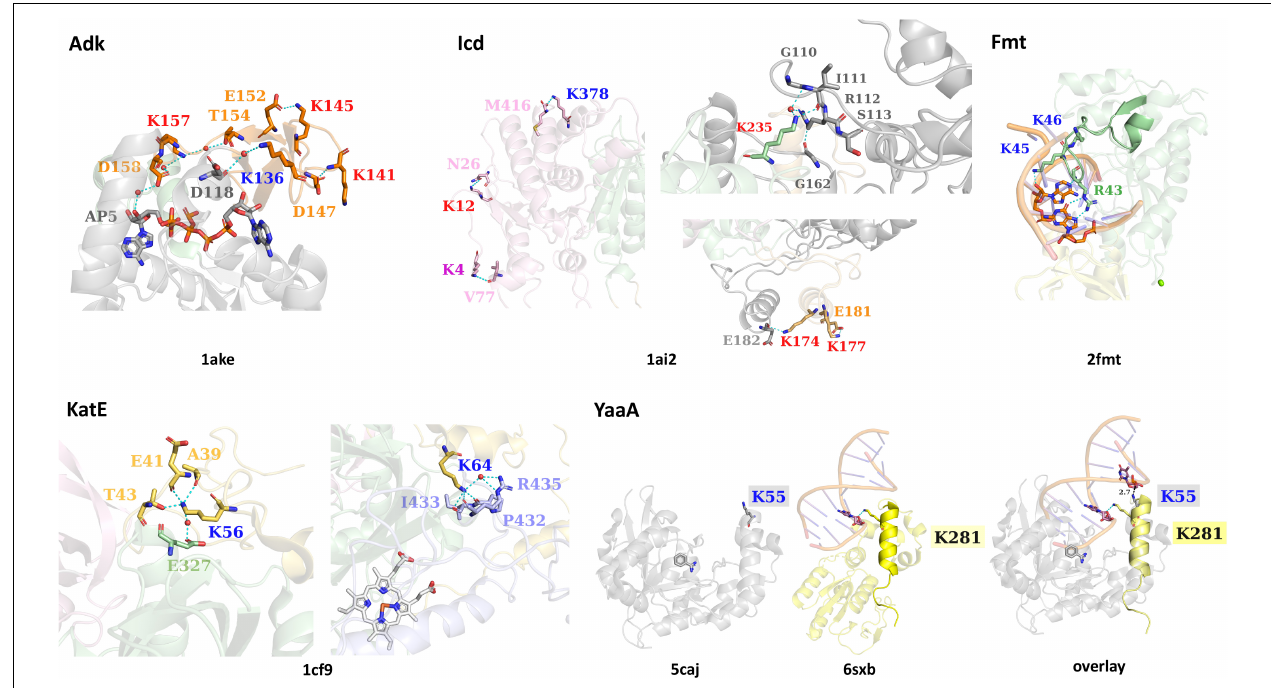
FIGURE 3 | The interactions of lysine residues identified as acetylated in E. coli K-12 KAT protein substrates Adk, Icd, KatE, Fmt, and YaaA. Structures of each substrate protein are colored by domains as in Figure 1 and PDB IDs are shown beneath each substrate protein structure. Residues surrounding KAT or AcP lysine sites of acetylation and interact via H-bonding are shown as sticks and colored by domain. Cyan dashes are used for H-bonding interactions and black dashes (in the YaaA structure) show distance measurements. Ligands are shown in sticks and water molecules are red spheres. Specific lysine residue labels are colored red for AcP acetylation sites, dark blue for KAT acetylation sites, and purple for both AcP and KAT acetylation site (in Icd). An overlay of the YaaA protein helix-hairpin-helix (HhH) domain compared to another DNA-binding protein with an HhH domain in complex with DNA (PDB ID: 6sxb) is also shown.